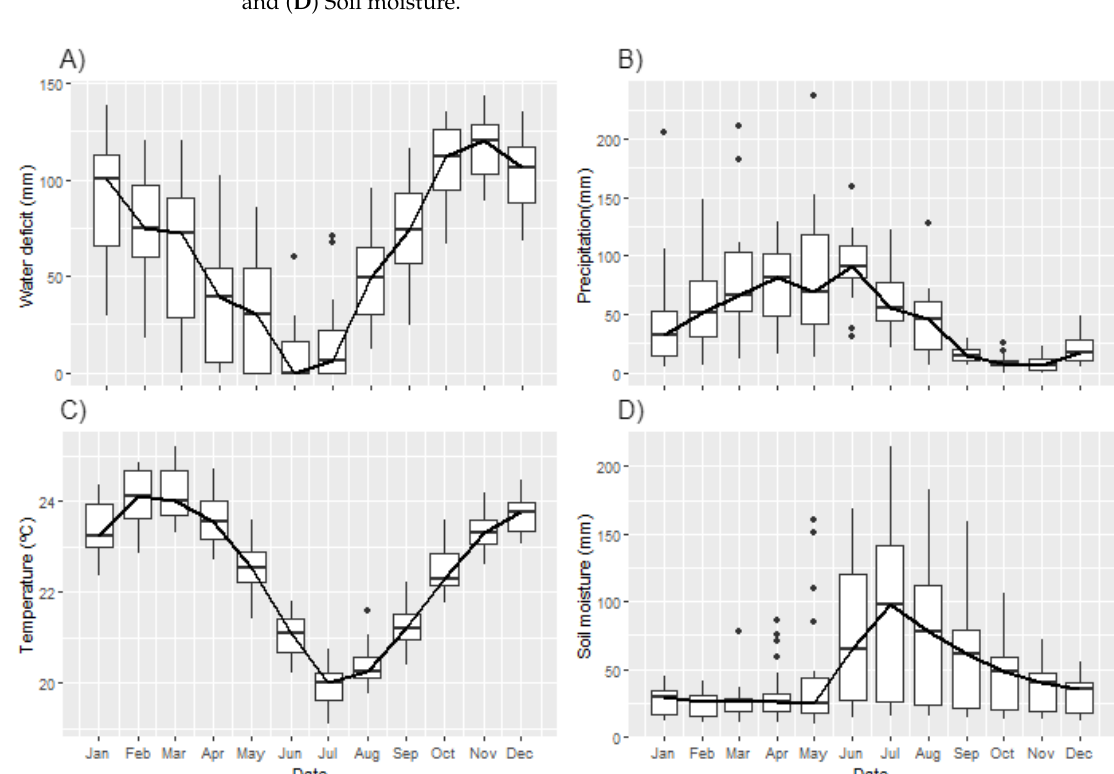
Figure 6. Environment drivers for BP in ( A ) Water Deficit, ( B ) Precipitation, ( C ) Air Temperature, and ( D ) Soil moisture.